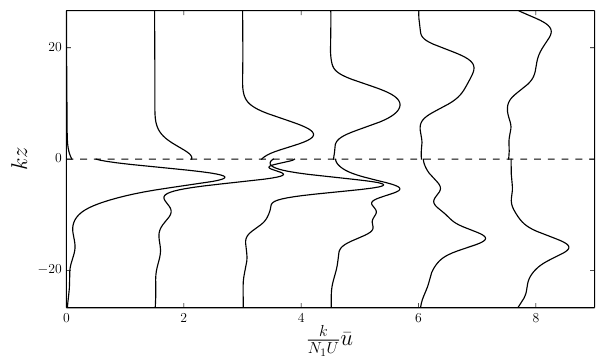
Figure 8. Vertical profiles of the mean flow in two layers for a se- quence of times. Each profile is shifted by a value of 1.5 for display. The parameter values are n 1 /k = 0.4, N 2 /N 1 = 2, (cid:15) = 0.025, and α = 0.1.